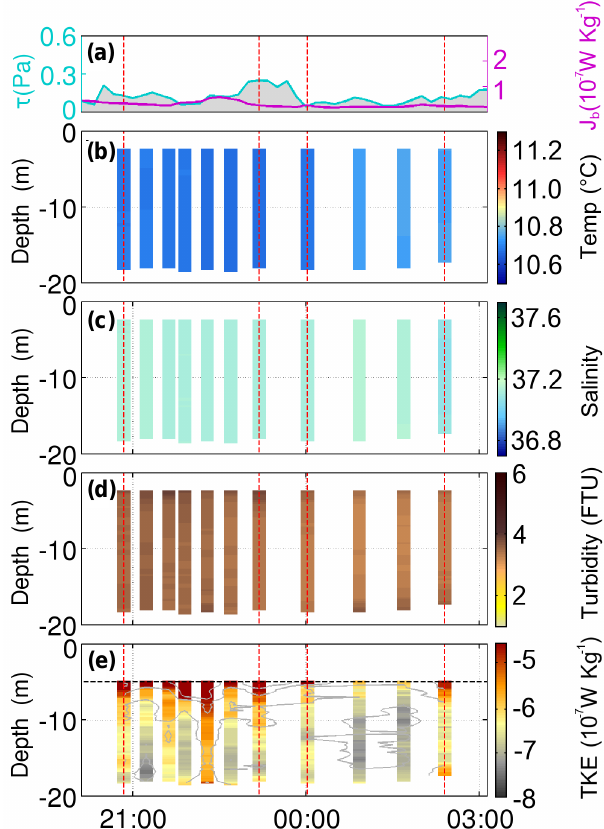
Figure 6. Hovmöller diagrams for Y01: (a) wind stress and buoy- ancy flux during the Y01, (b) temperature profiles, (c) salinity pro- files, (d) turbidity profiles in FTU, (e) turbulent kinetic energy dissipation rate in logarithmic scale (contours spaced in log of 1Wkg − 1 ) . Red dashed lines show the time of collection of the Y01 casts reported in top panels of Fig. 8.